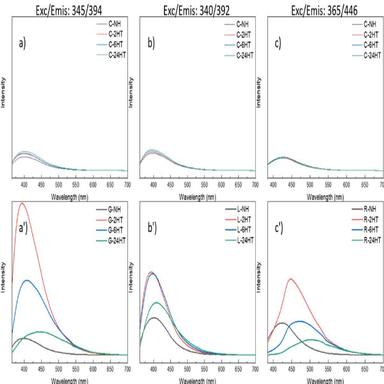
Fluorescence emission (Emis) spectra of fish gelatin-based films as a function of excitation (Exc) wavelength, saccharide: a') glucose (G); b') lactose (L); and c') ribose (R), and heating time (non-heated (NH), heat-treated (HT) for 2, 6 and 24 h). Films with no saccharide were used as controls (C, a-c). (n = 3).